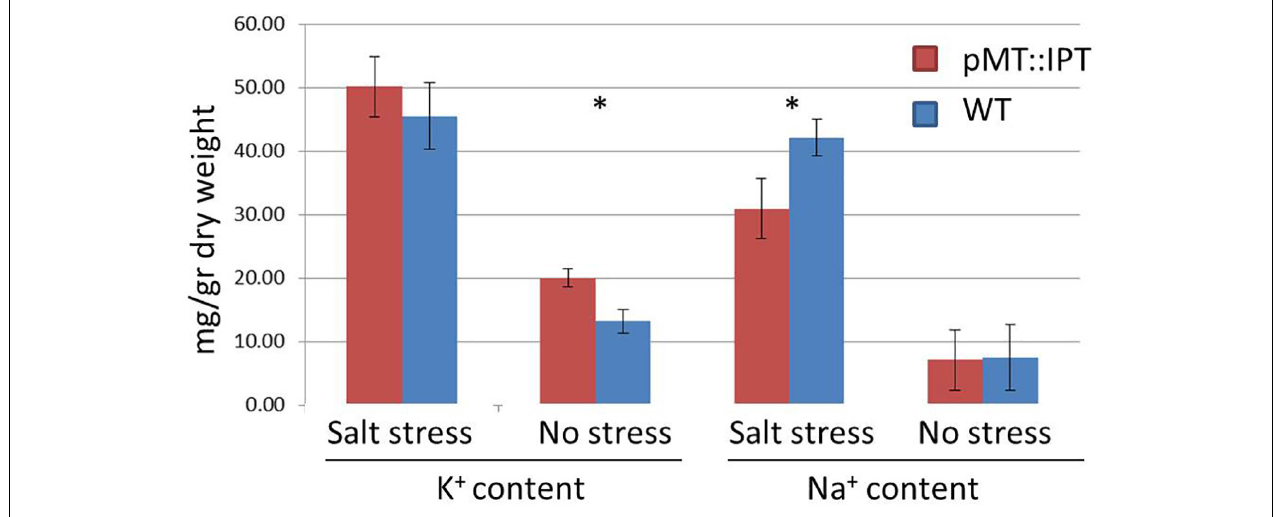
FIGURE 6 | Na + and K + content in pMT:IPT and WT tobacco plants under salinity stress and non-stressed conditions. Three-week old tobacco plants were watered with NaCl solution (100 and then 200 mM) for 3 weeks. Asterisk refers to statistically significant difference between treatments ( p < 0.05). Values correspond to means ± SE of three independent